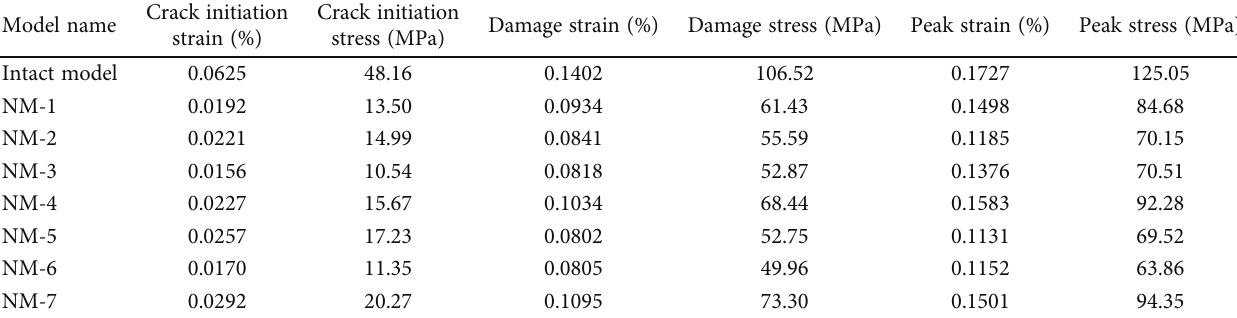
Table 2: Crack initiation, damage, and peak stress and strain of each